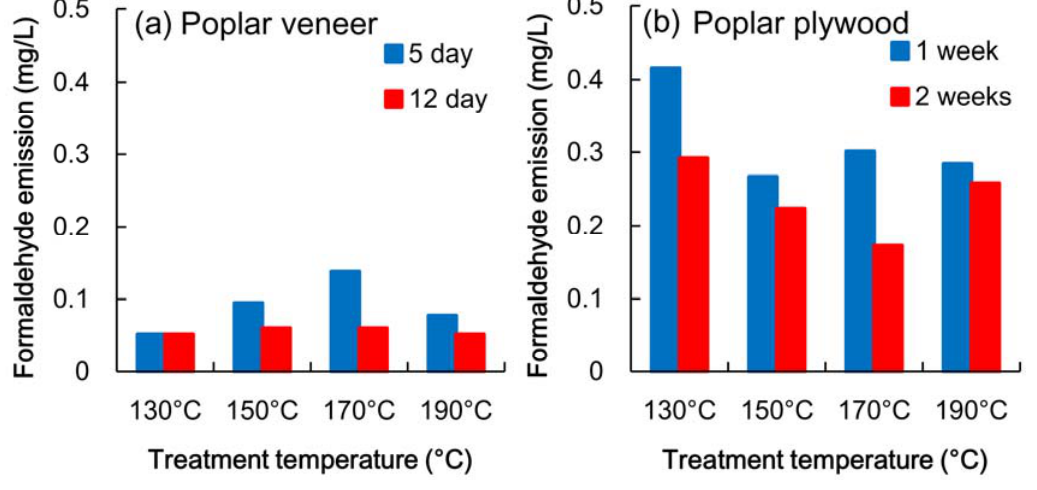
Figure 2. Formaldehyde emission of ( a ) heated poplar veneer and ( b )